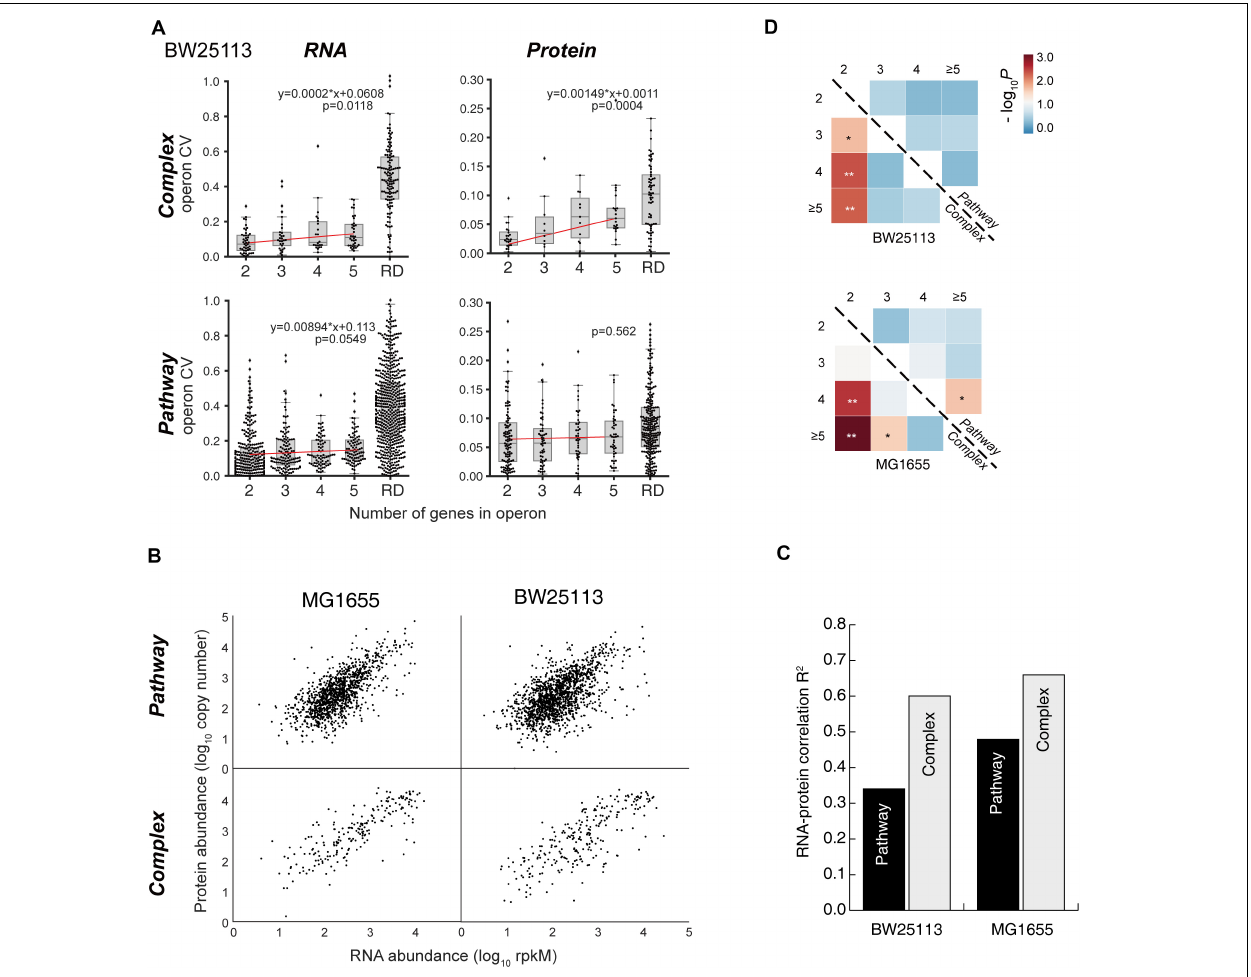
FIGURE 4 | Length-dependence of operon stoichiometry control. (A) Linear regression analysis of gene CVs at RNA and protein levels within operon that encodes proteins forming complexes or involving in the metabolic pathways in BW25113 strain. P -values of the regression are indicated in the plots. P < 0.05 are considered significant. RD, randomized control. (B) The RNA–protein scatter plots of the gene expression levels of the “Complex” and “Pathway” operons in two strains, respectively. (C) The correlation coefficient R 2 of the RNA–protein correlation shown in (B) panel. (D) The mutual P -value (Mann–Whitney U test) matrix of the protein CV within “Pathway” operons and “Complex” operons, respectively. ∗ P < 0.05; ∗∗ P <